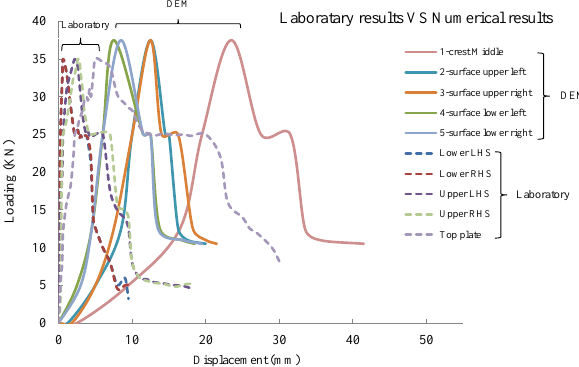
Figure 16. Loading force against displacement curves of the slope Figure 16 Loading force against displacement curves of the slope at different measuring points from at different measuring Laboratory and Numerical results